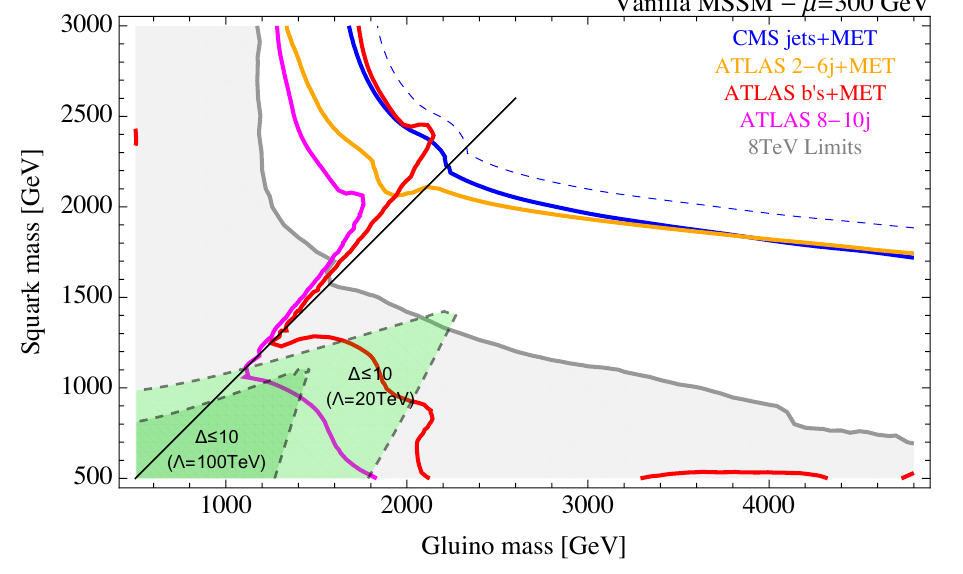
Figure 2 . Limits on the \vanilla" SUSY model with m ~ = (cid:22) = 300 GeV as a function of the H gluino and the degenerate squarks masses. The combined limits for (cid:22) = 100 GeV are virtually indistinguishable and we do not show them. All limits are conservative as they already include a factor of 1.5 e(cid:14)ciency reduction to account for possible recasting errors. The nominal limits without recasting uncertainty are shown in dashed blue. The gray shaded area was already excluded by 8 TeV searches (using the framework of refs. [9, 84, 85]). The shaded green regions with dashed lines show the (cid:1) (cid:20) 10 naturalness bound on the gluino and stop masses for (cid:3) = 20 and 100